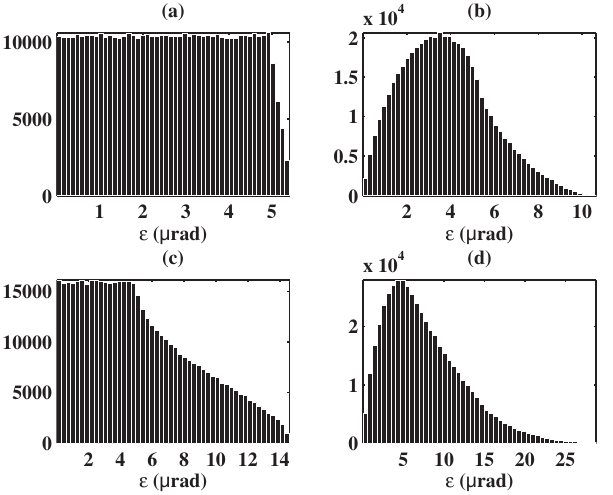
FIG. 23. Distributions of the misalignments of MPS (parallelism) ε obtained with Δ ε 00 ¼ 20 μ rad. (a) Of the first MPS for θ ¼ 22 . 5 °. (b) Of the n th MPS, with n > 1 for θ ¼ 22 . 5 °. (c) Of the first MPS for θ ¼ 70 °. (d) Of the n th MPS, with n > 1 for θ ¼ 70